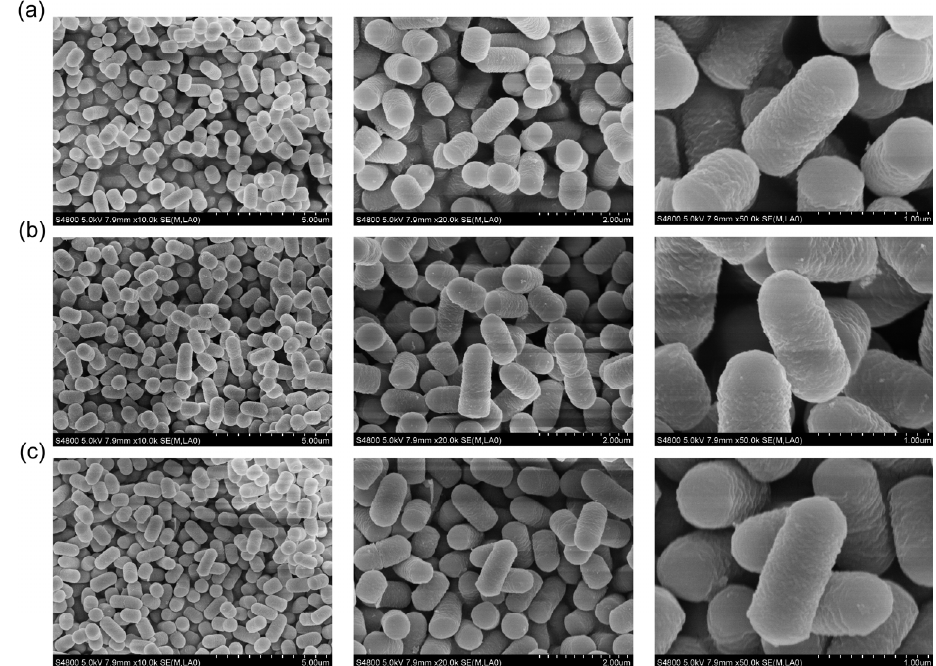
Figure 3. Bacterial morphology images of Lactobacillus plantarum ( L. plantarum ) WCFS1 and trans- formed L. plantarum WCFS1 samples using field emission scanning electron microscopy (SEM) at different magnifications. ( a ) L. plantarum WCFS1, ( b ) W-pSIP403 and ( c ) W-0373-mGLP-1.